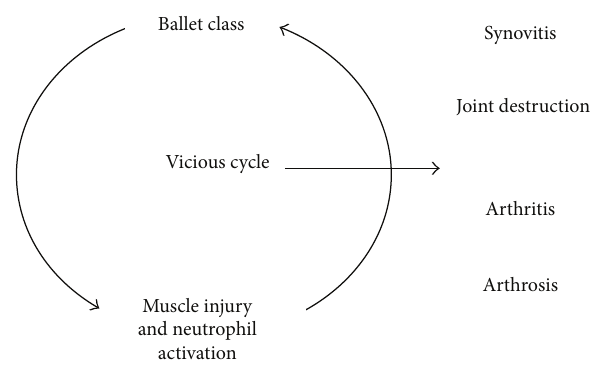
Figure 4: Chronic inflammations as a result of ballet dancing class causes subclinical systemic inflammation and the activation of the function of neutrophils in the chronic inflammation may be the main factor involved in the genesis of arthritis and other inflamma- tory joint diseases in